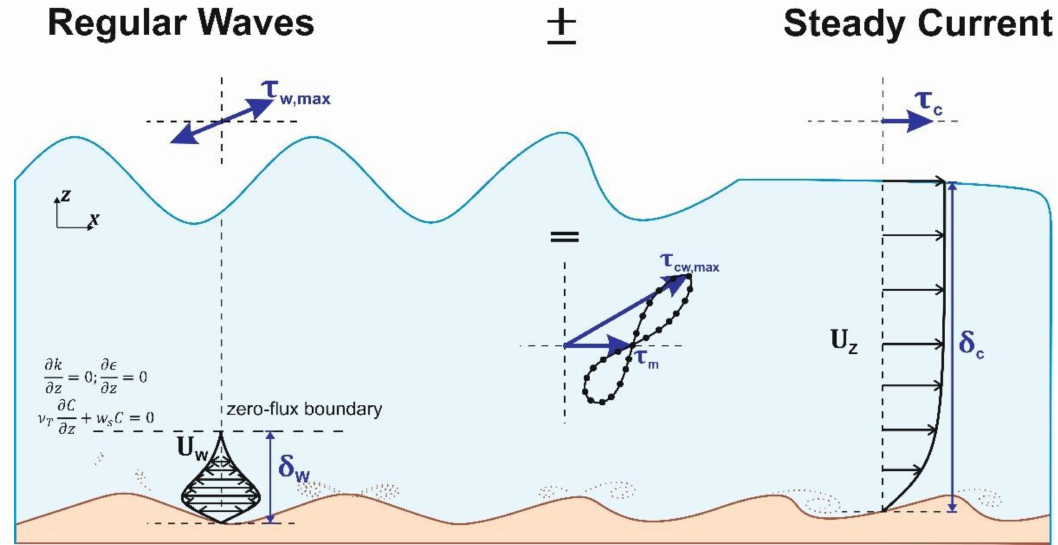
Figure 1. An illustration of boundary layer structure under regular waves ( δ w ) and steady currents ( δ c ), and the associated shear stresses. The vectorial addition of mean ( τ m ) and maximum ( τ cw , max ) stresses in combined oscillatory (Uw) and steady (Uz) flows is shown, as is the zero-flux boundary condition, whereby k : kinetic energy, (cid:15) : energy dissipation, ν T : eddy viscosity, w s : sediment settling velocity, and C : sediment